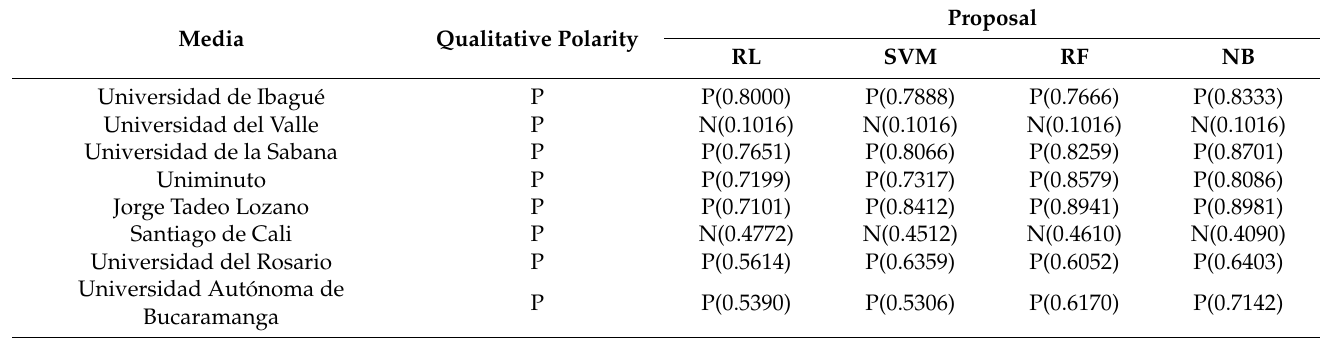
Table 7. Sentiment analysis for the Colombian conflict dataset. We compare the behavior of our proposal with qualitative labels for each media. For our approach, we present the predicted polarity and the ratio of documents whit positive semantic